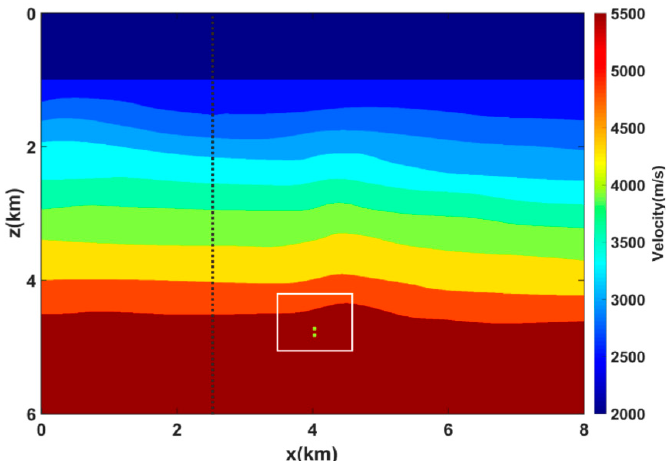
ω denotes the Green’s function be- tween the source ' x and the receiver point x at ω angular frequency. In the second computational state, only the truncated space D in exists. Figure 2. A simple model and the target zone (area enclosed by the solid white lines). VSP receivers are set along the black dotted line at 2500 m in the X direction. Combining Equation (6) multiplied by (x,x ) in vr G and Equation (7) multiplied by (x,x ) all , and integrating both sides of the combined equation over D in , we have, and the Green’s function of the point source x vr is noted as (red arrowed line in Figure 2), that is,